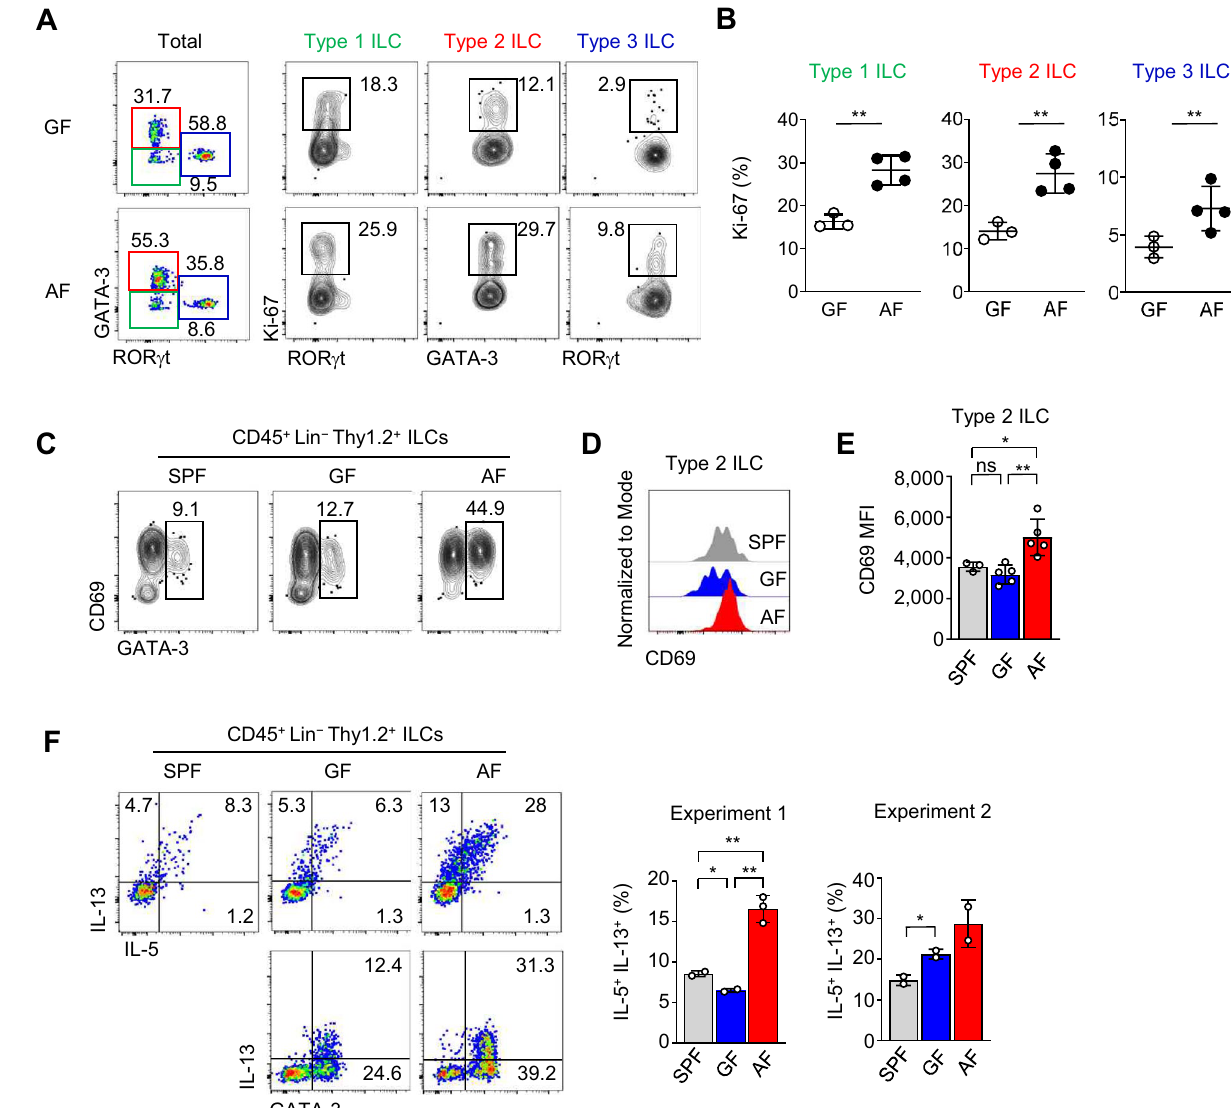
Figure 3. ILC2s of AF mice have activated and proliferating phenotypes. Single-cell suspensions of the siLP mononuclear cells isolated from indicated mice were analyzed by flow cytometry. ( A – B ) Dot plots show the expressions of Ki-67 in each ILC subset in GF and AF mice (A). Graphs show statistical analysis of Ki-67 expression in ILC populations in the lamina propria of the gut from GF or AF mice. ( C ) Contour plots show CD69 expressions in GATA-3+ type 2 ILCs of indicated mice. ( D – E ) The histogram shows CD69 expressions (D), and the graph shows statistical analysis of CD69 MFI (N=4~5) in the indicated mice (E). ( F ) Dot plots show intracellular effector cytokines (IL-13, and IL-5) in gated Thy1.2+ Lin– total ILCs from the siLP of indicated mice after 4 hr stimulation with PMA and ionomycin in the presence of Brefeldin A and Monensin. Representative data from three independent experiments are shown. Numbers indicate frequencies of cells in adjacent gates, and each dot represents an individual mouse. Horizontal bars indicate mean values, and error bars show SD. *p<0.05, **p<0.01. NS, not significant (unpaired two-tailed student t-test). siLP, small intestinal lamina propria; ILC, innate lymphoid cell; SPF, specific pathogen-free; GF, germ-free; AF,